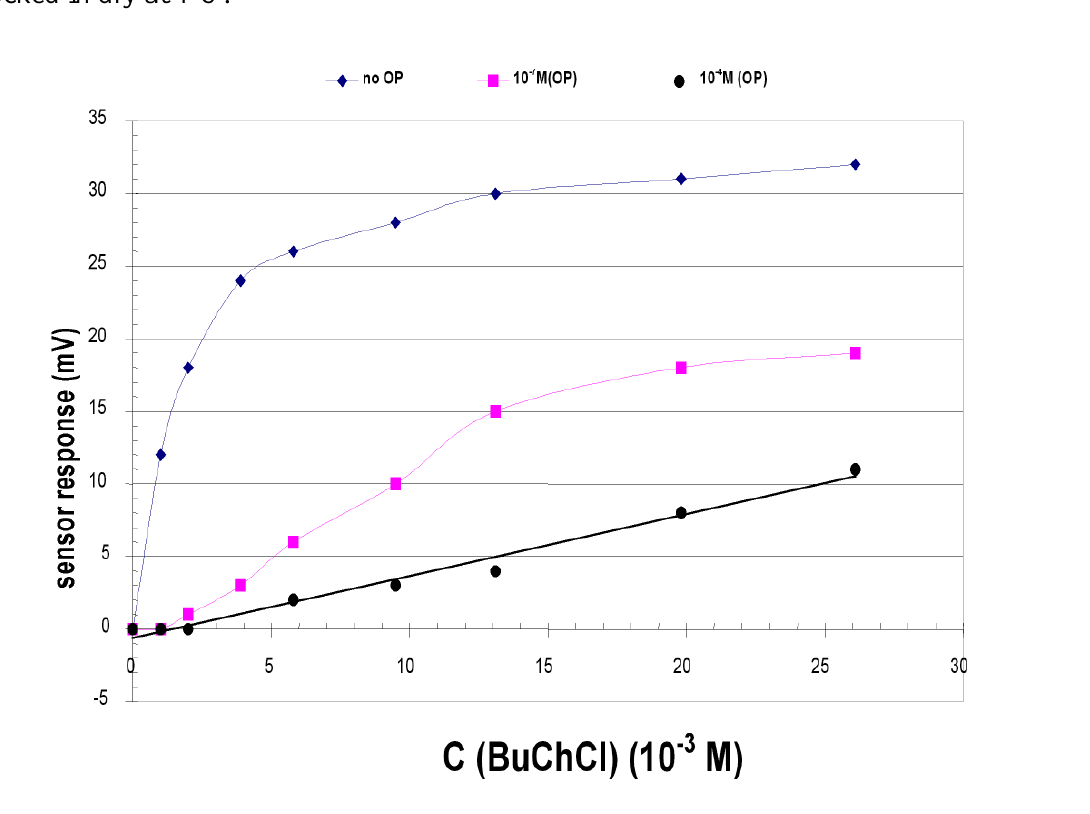
Figure 5. Inhibition effect on the response of the ENFET with a mixed BuChE/ODA LB film by